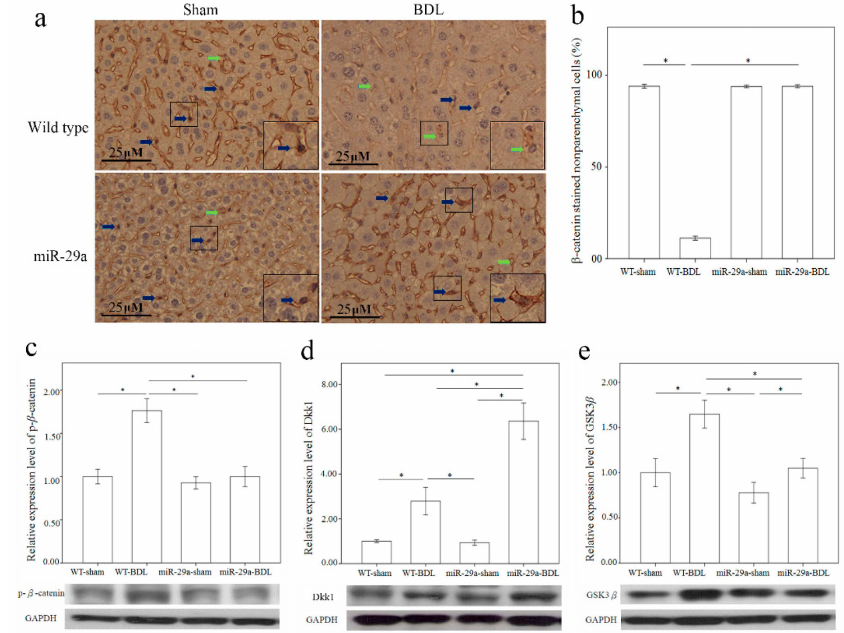
Figure 4. Overexpression of miR-29a in the murine model caused the upregulation of β -catenin ( a , b ), and Dkk1 ( d ) as well as the downregulation of phospho- β -catenin ( c ) and GSK3 β ( e ) in the liver of mice following bile duct ligation. The β -catenin immunoreactivity staining mainly in cytoplasm of hepatocytes and nucleus of the non-parenchymal cells morphologically identical to HSC or Kupffer cells (Figure 4a, inset). Comparing to the sham group of WT mice, which was constantly expressed in the nucleus of the non-parenchymal cells (blue arrow), there was significantly lower β -catenin immunoreactivity (green arrow) in the liver tissues of the BDL group of WT mice ( p < 0.001) (Figure 4a,b). Furthermore, miR-29a overexpression significantly upregulated the nuclear β -catenin immunoreactivity in miR-29aTg mice with cholestasis in comparison to WT littermates ( p < 0.001). Data are expressed as mean ˘ SE (standard error) in the six samples from miR-29a transgenic mice and the six samples from their WT littermates. * indicates p < 0.05 between the